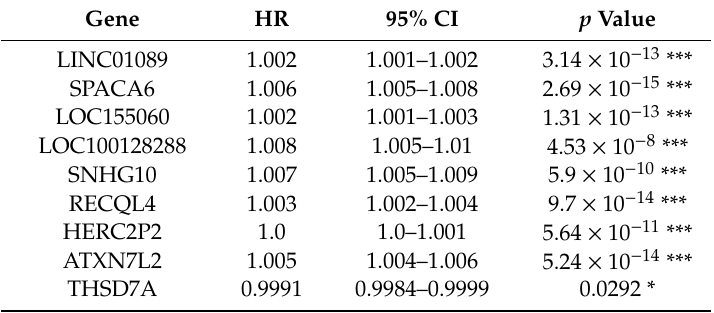
Figure 6. Association of SigIQGAP1NW with worse clinical features of ccRCC. Stage 1 and 2 are expressed as “0”, while Stage 2 and 4 are represented as “1”. T stages 1 and 2 are converted to “0”; T3 and T4 are combined to “1”. Grades 1 and 2 are used at “0”; and Grades 3 and 4 are converted to “1”. SigIQGAP1NW scores are used for analysis. Table 4. Association of SigIQGAP1NW component genes with poor OS of ccRCC.